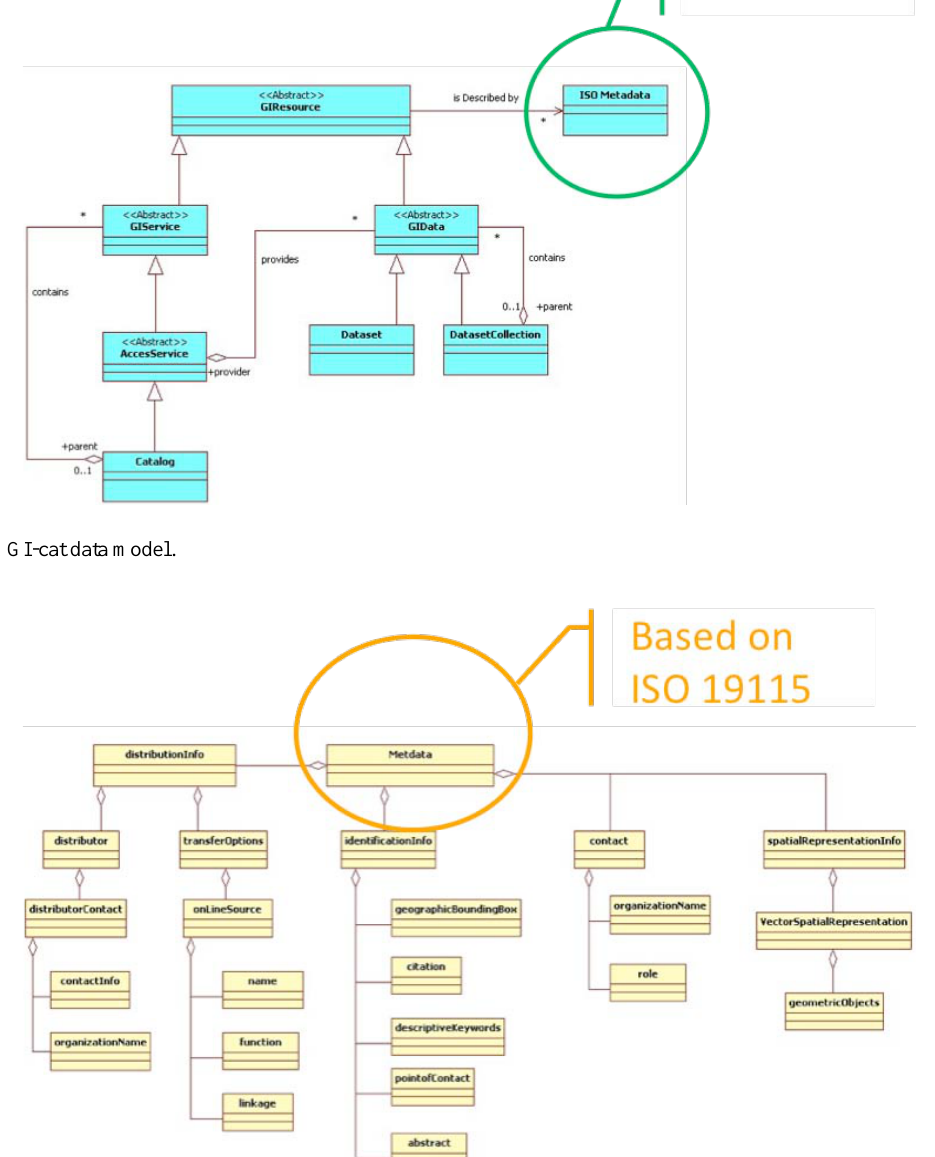
Fig. 5. Simplified CDI Data Model for a dataset